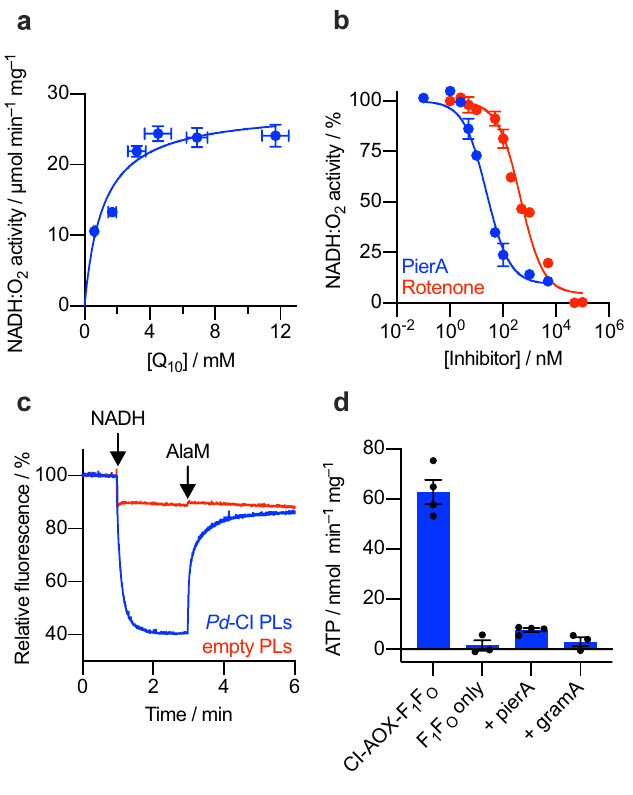
Figure 4. Characterization of Pd -CI in liposomes. ( a ) K M curve for Q 10 in proteoliposomes. The K M and V max values were determined to be 1.1 ± 0.2 mM and 27.9 ± 1.2 µmol min –1 (mg CI) –1 , respectively (± S.E.M. of the fit). ( b ) Inhibition by piericidin A and rotenone. The measured IC 50 values for piericidin A and rotenone were 24 ± 3 nM and 452 ± 48 nM, respectively (± S.E. of the fit). ( c ) Proton pumping measured by an ACMA fluorescence quench assay. Proton pumping was initiated by addition of 1 mM NADH and proteoliposomes uncoupled by addition of 25 µg mL –1 alamethicin (AlaM). Liposomes without Pd -CI were added as a control. ( d ) Coupling Pd -CI catalysis to ATP synthesis. Pd -CI was co-reconstituted in liposomes with E. coli ATP synthase (CI-AOX-F 1 F O ) and NADH-coupled ATP production was measured as luminescence using a luciferase-based assay. No ATP was generated by proteoliposomes containing only ATP synthase (F 1 F O only) while addition of 2 μM piericidin A (pierA) or 20 μg mL –1 gramicidin A (gramA) inhibited ATP synthesis. Alternative oxidase (AOX) was directly added to the assay mixture at 20 µg mL –1 in panels ( a – c ) and at 5 µg mL –1 in panel ( d ). See “Materials and methods” for the assembly of proteoliposomes and other assay